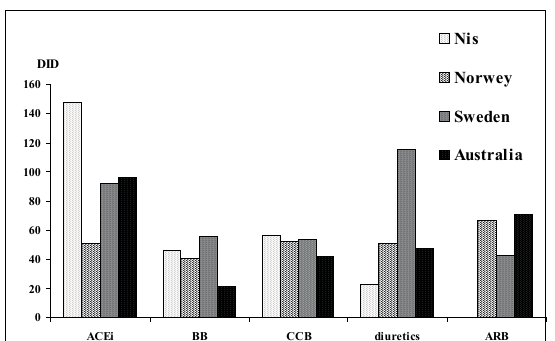
Figure 5. Comparison of consumption of antihypertensive drugs in Nis region and Nordic country (Norwey, Sweden) and Australia in 2007.